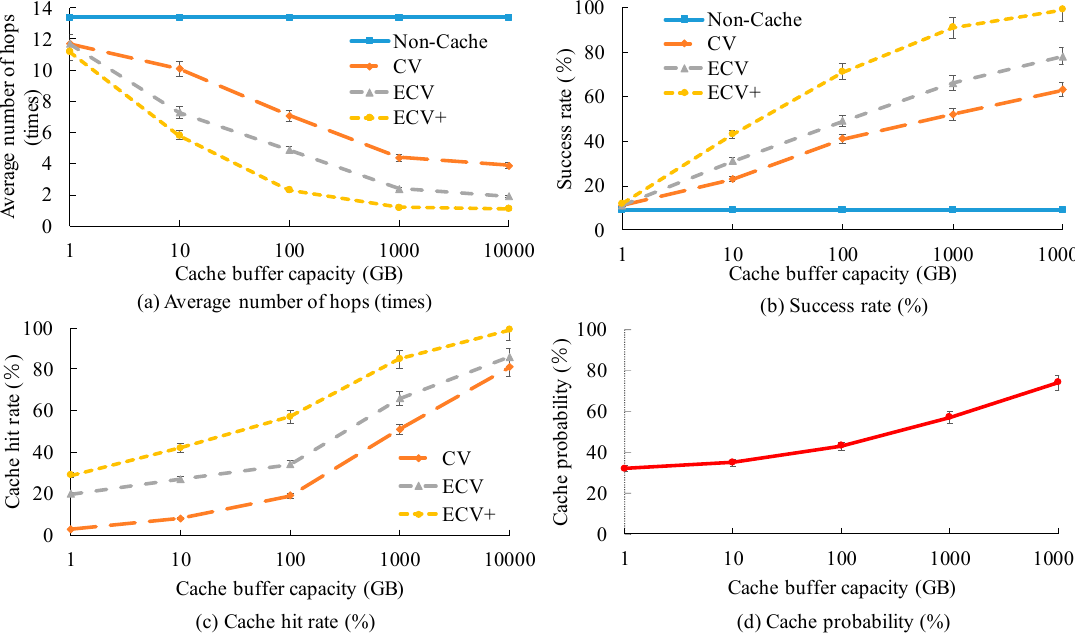
Figure 6. Results under different cache buffer capacity (information generation interval is 4 s and the number of vehicles is 500).